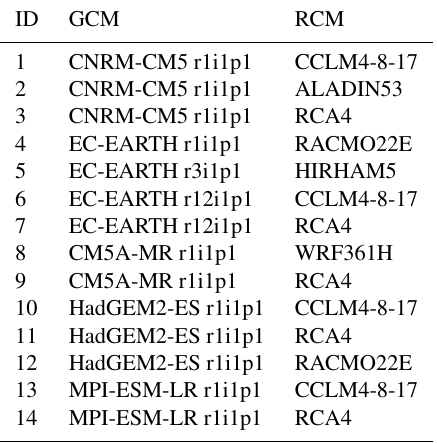
Table 2. EURO-CORDEX models used for this study (Jacob et al., 2014). The model resolution is 12 . 5 × 12 . 5km. The rip index refers to realization, initialization method and physics version used for